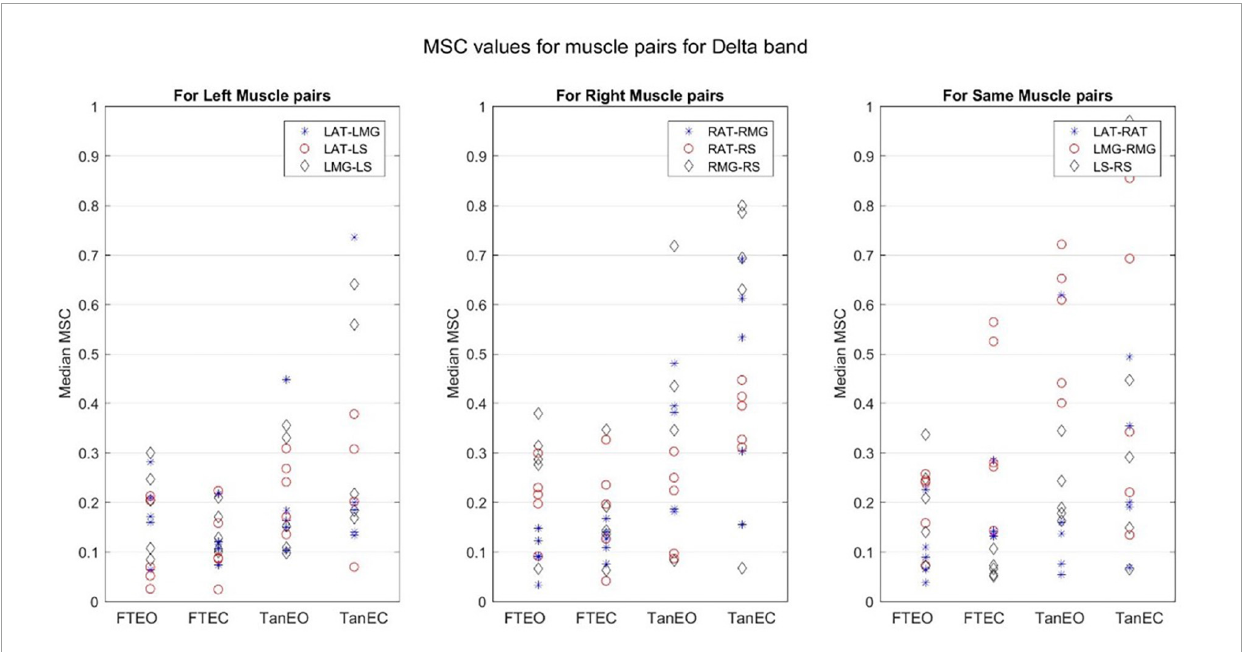
FIGURE8 Magnitude-squared-coherence plot for different muscle pairs under different standing conditions for delta frequency band (1.179–4.1016 Hz) for a single participant for all individual trials. The plot shows coherence between different muscle pairs for the most to least stable postural standing positions in the delta band. It can be seen how coherence for different muscle pairs have increased and has the highest coherence value in the lowest frequency band.